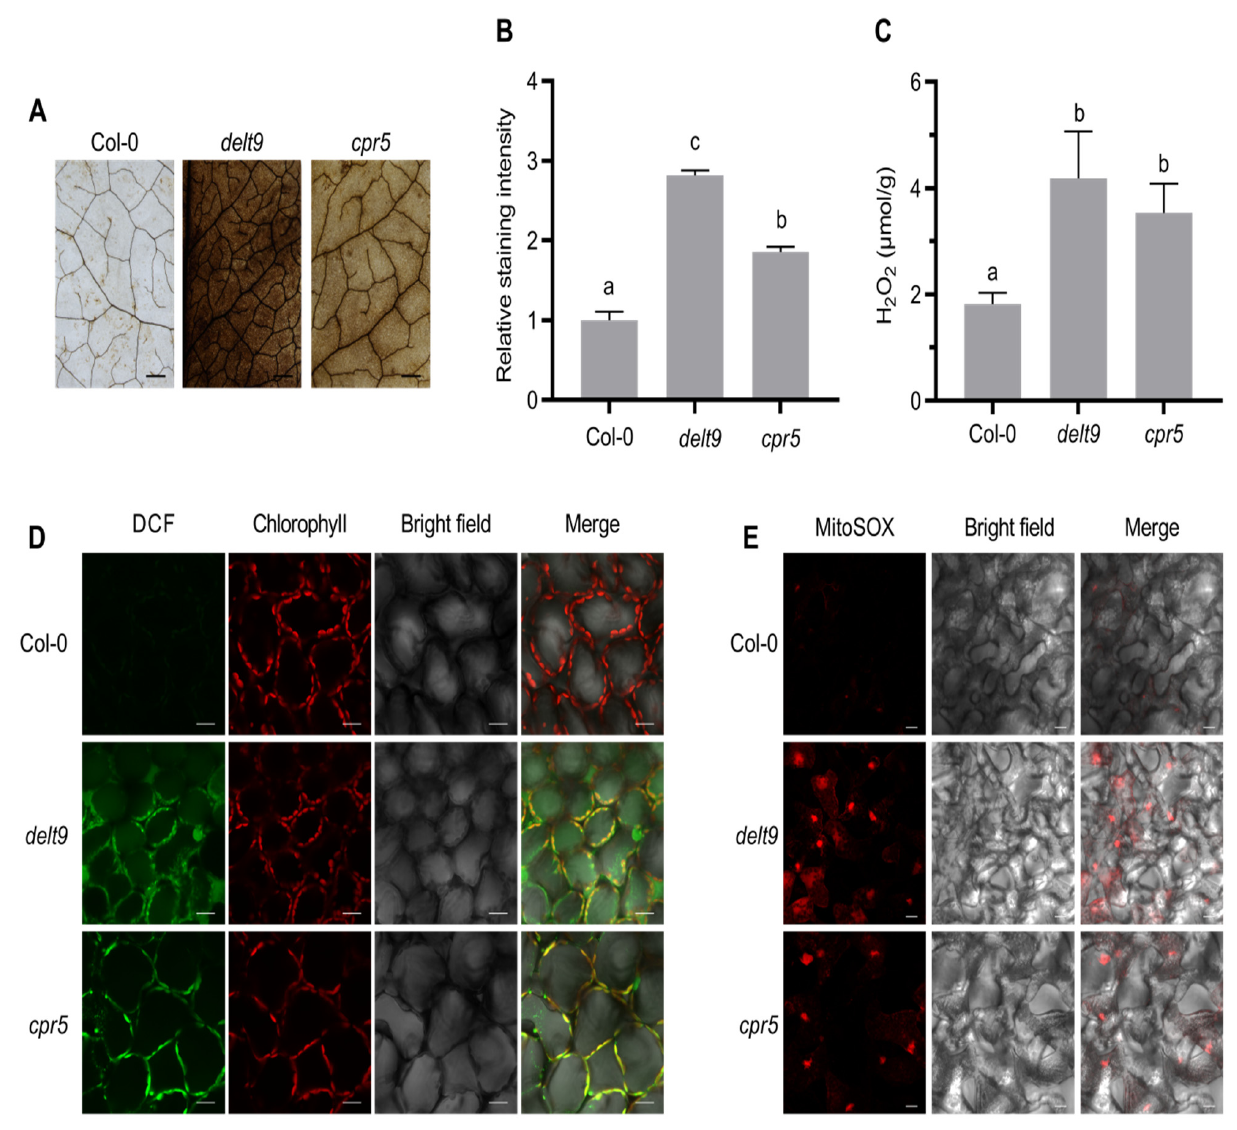
Figure 2. cpr5 mutants show increased ROS accumulation. ( A ) Representative images of leaves after 3,3 (cid:48) -diaminobenzidine (DAB) staining. The 5th–7th rosette leaves from 4-week-old plants were detached and stained with DAB solution. Scale bars = 2 mm. ( B ) Quantification of DAB staining intensity in ( A ). Relative DAB staining intensity per unit leaf area was measured using the ImageJ software. Data are means ± SE (n = 12). Letters above bars indicate significantly different values among groups ( p ≤ 0.05; one-way ANOVA). ( C ) Quantification of H 2 O 2 levels by titanium sulfate colorimetry. H 2 O 2 was extracted from the 5th–7th rosette leaves. Data are means ± SD (n = 3). Letters above bars indicate significantly different values among groups ( p ≤ 0.05; one-way ANOVA). ( D ) ROS accumulation detected by 2,7-dichlorodihydrofluorescein diacetate (H 2 DCFDA) staining. The 5th–7th rosette leaves from 4-week-old plants were stained with 10 µ M H 2 DCFDA for 20 min, and then green fluorescence was visualized by confocal microscopy. Representative images are shown. Scale bars = 20 µ m. ( E ) Mitochondrial superoxide levels detected by MitoSOX Red staining. The 5th–7th rosette leaves were stripped off their lower epidermis and subjected to MitoSOX Red solution to observe their mitochondria. Scale bars = 20 µ